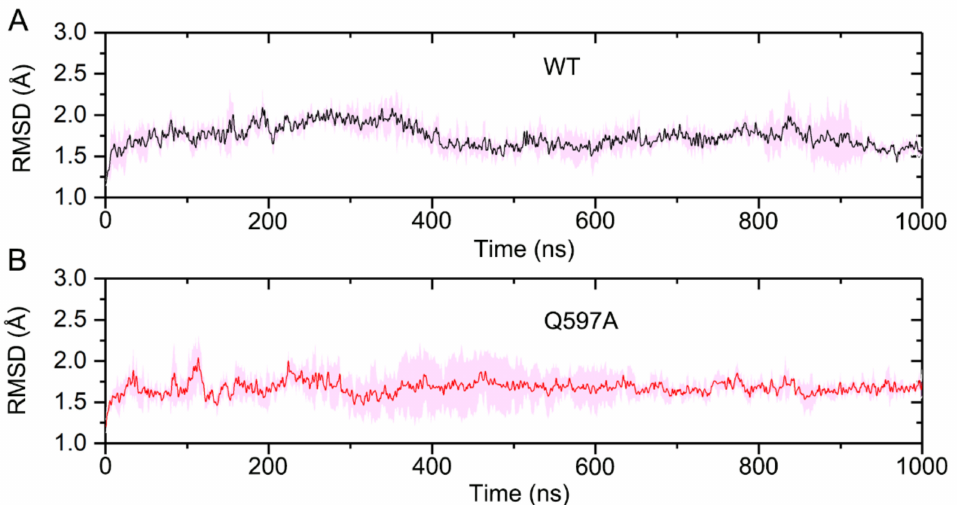
Figure 2. The root-mean-square deviation (RMSD) of all C α atoms in the SENP1 − SUMO1 complex for the WT ( A ) and the Q597A mutant; ( B ) averaged over three independent replicates. Transparent shading represents standard